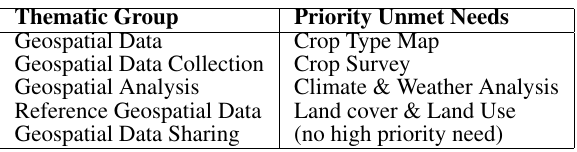
Table 1. Priority unmet needs by thematic